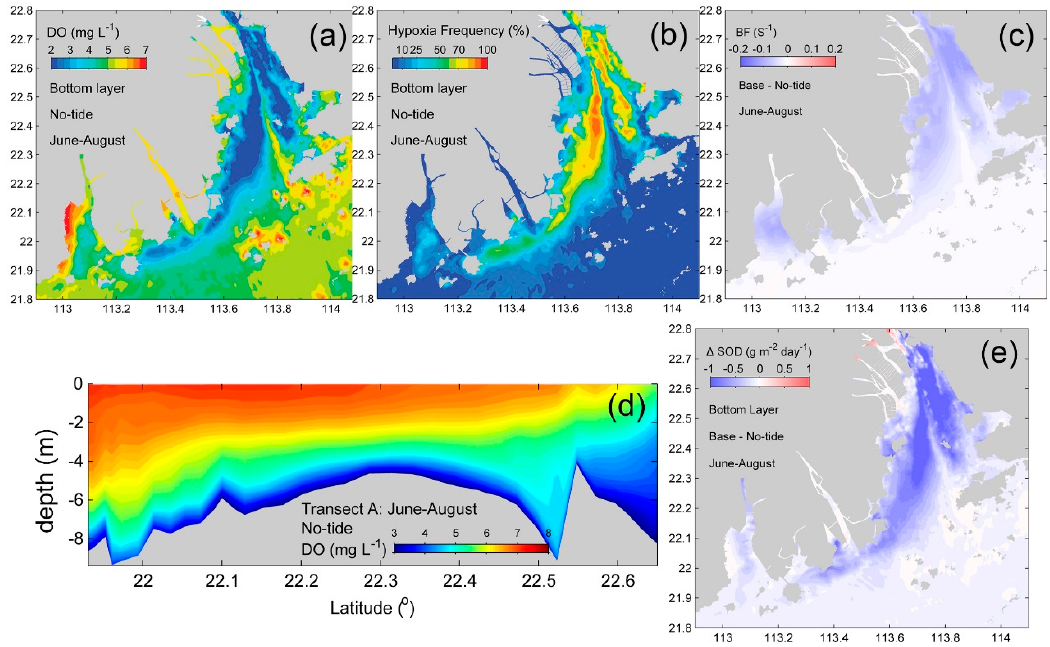
Figure 17. Spatial distribution of the averaged ( a ) bottom DO concentration and ( b ) HF during summer. ( c ) Deviation in the summer stratification strength (BF) of the no-tide run from the base run. ( d ) DO concentration profile along the PRE. ( e ) Difference in SOD between the base run and no-tide run.